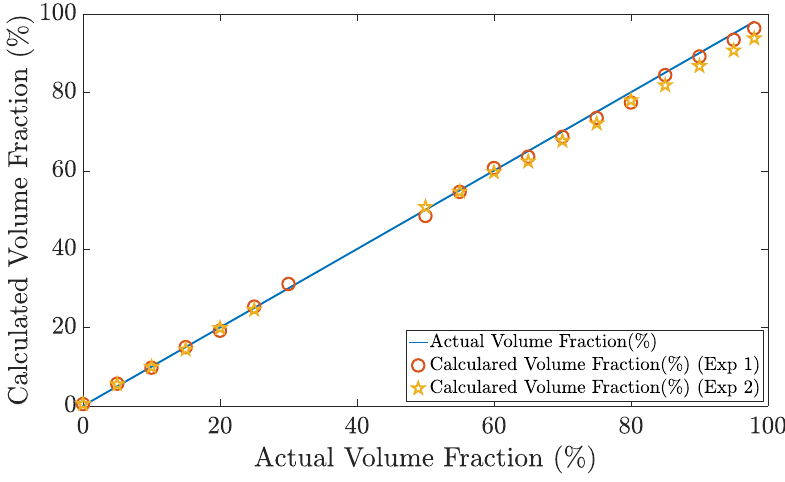
Figure 7. Calculated versus actual volume fractions of water obtained from two-phase oil-water flows based on controlled flow loop experimental data. Details of the experimental setup can be found in